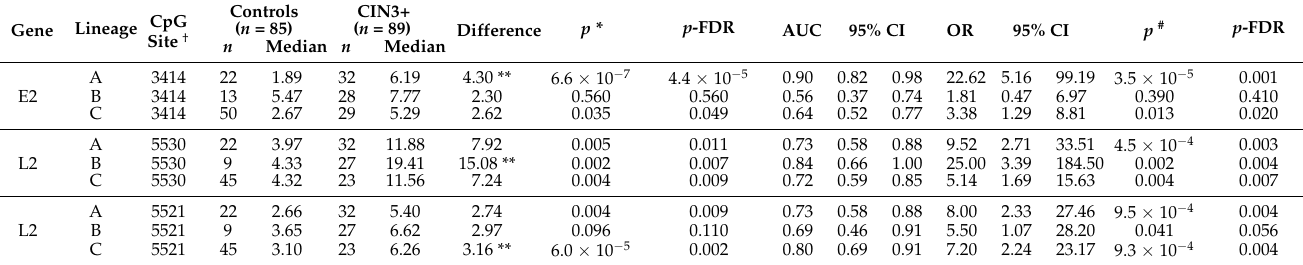
CIN3+, with controls as the